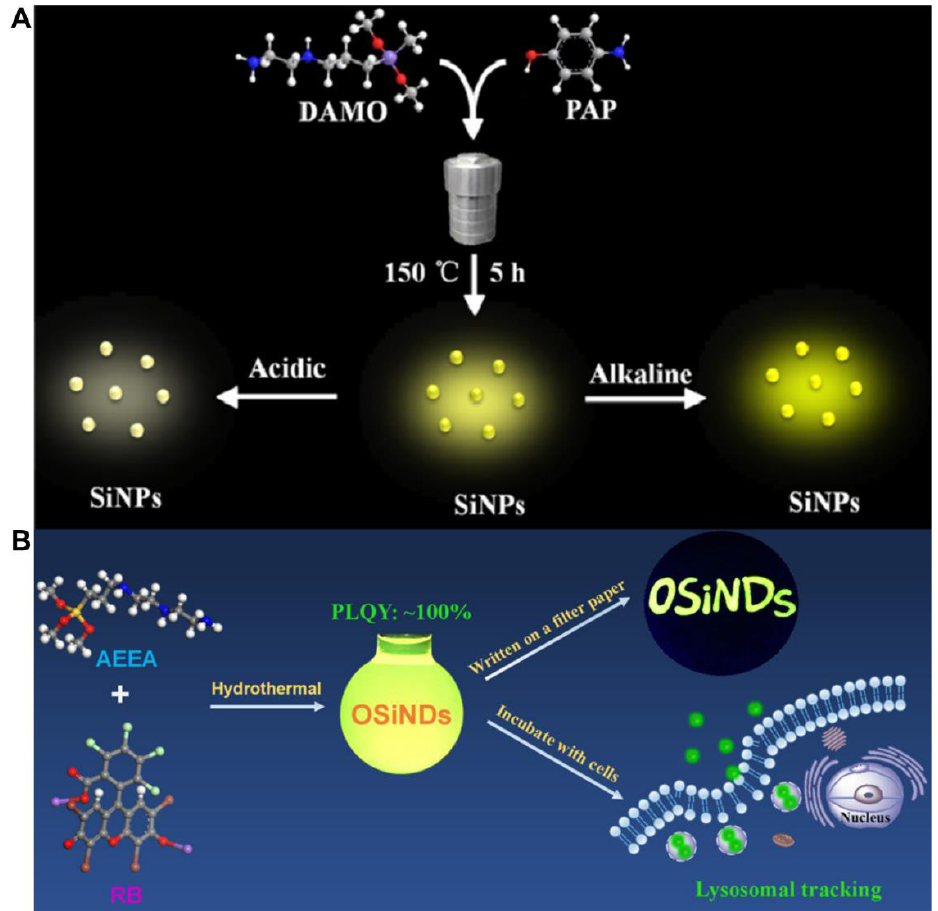
Figure 2. ( A ) Schematic illustration of the one - pot synthesis of yellow - green - emissive SiNPs and SiNPs for pH detection. Reproduced from [27], with permission from American Chemical Society, 2021. ( B ) Schematic illustrating the synthesis of green-emitting organosilica nanodots (OSiNDs) with ultrahigh quantum yields and their application in long-time lysosomal imaging. Reproduced from [48], with permission from American Chemical Society, 2018.